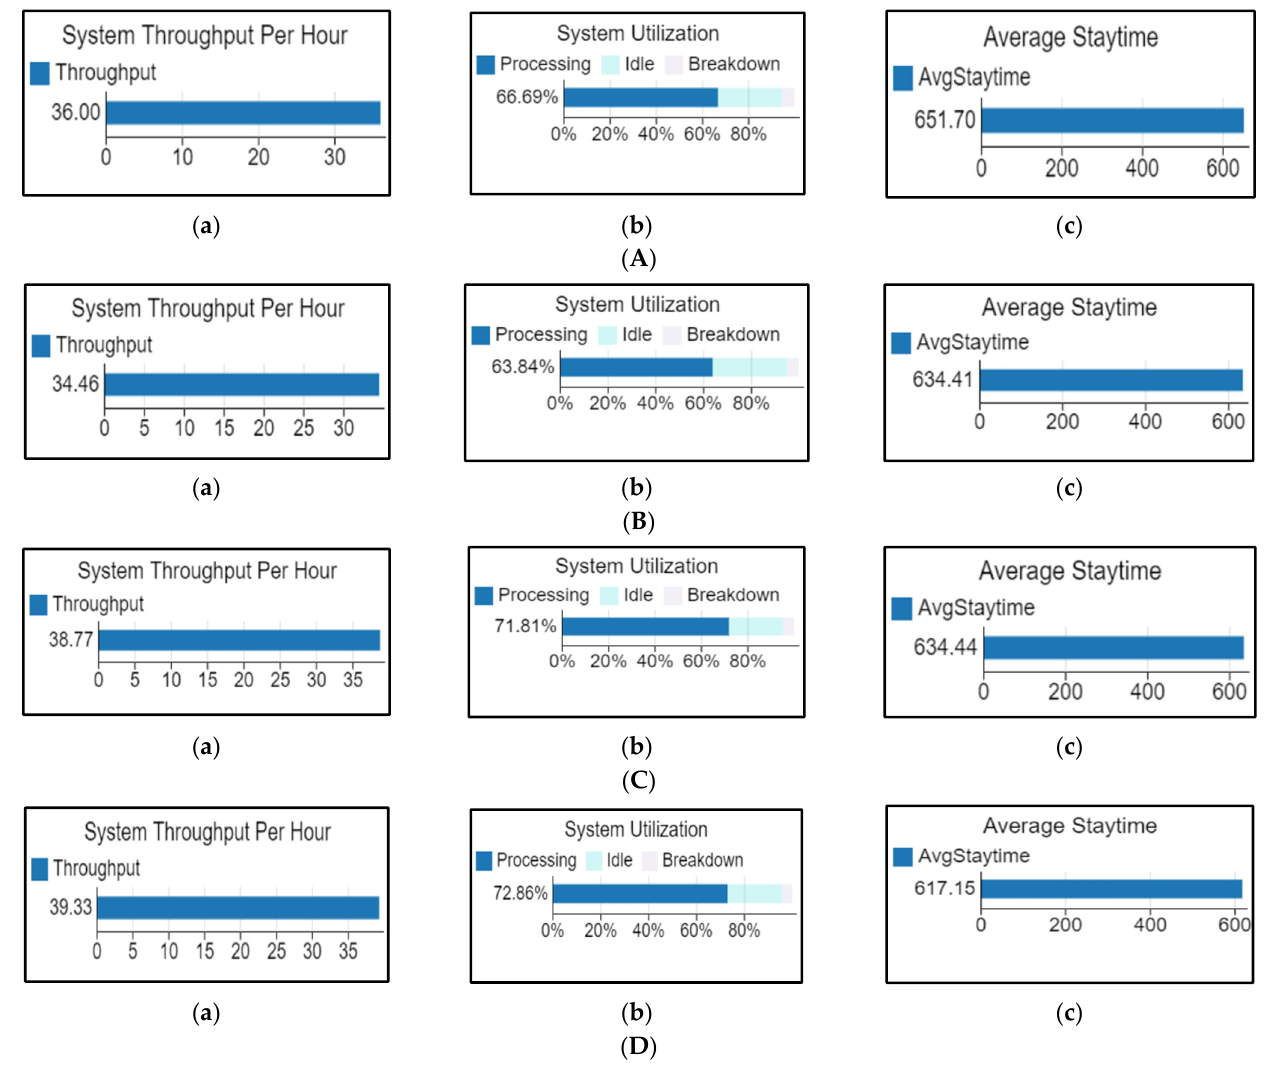
Figure 7. Simulation results with breakdown of machines. ( A ) One-Degree Flexible System. ( a ) System Throughput rate. ( b ) System Use. ( c ) Average stay time. ( B ) Two-Degree Flexible System. ( a ) System Throughput rate. ( b ) System Use. ( c ) Average stay time. ( C ) Semi-Flexible System. ( a ) System Throughput rate. ( b ) System Use. ( c ) Average stay time. ( D ) Fully Flexible System. ( a ) System Throughput rate. ( b ) System Use. ( c ) Average stay time. Table 7. Collected values of the parameters effect on flexible machine systems for 5000 number of